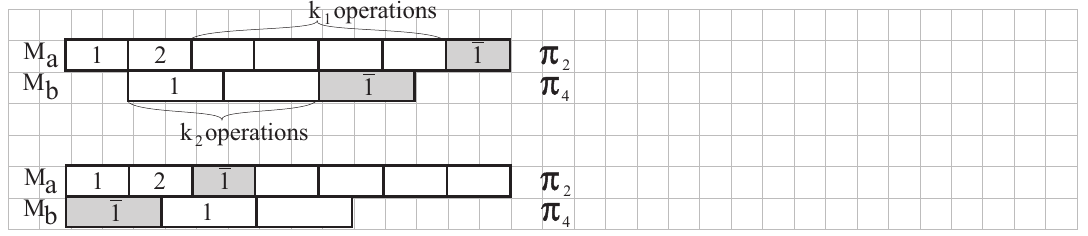
Figure 2. Illustration for the proof of Lemma